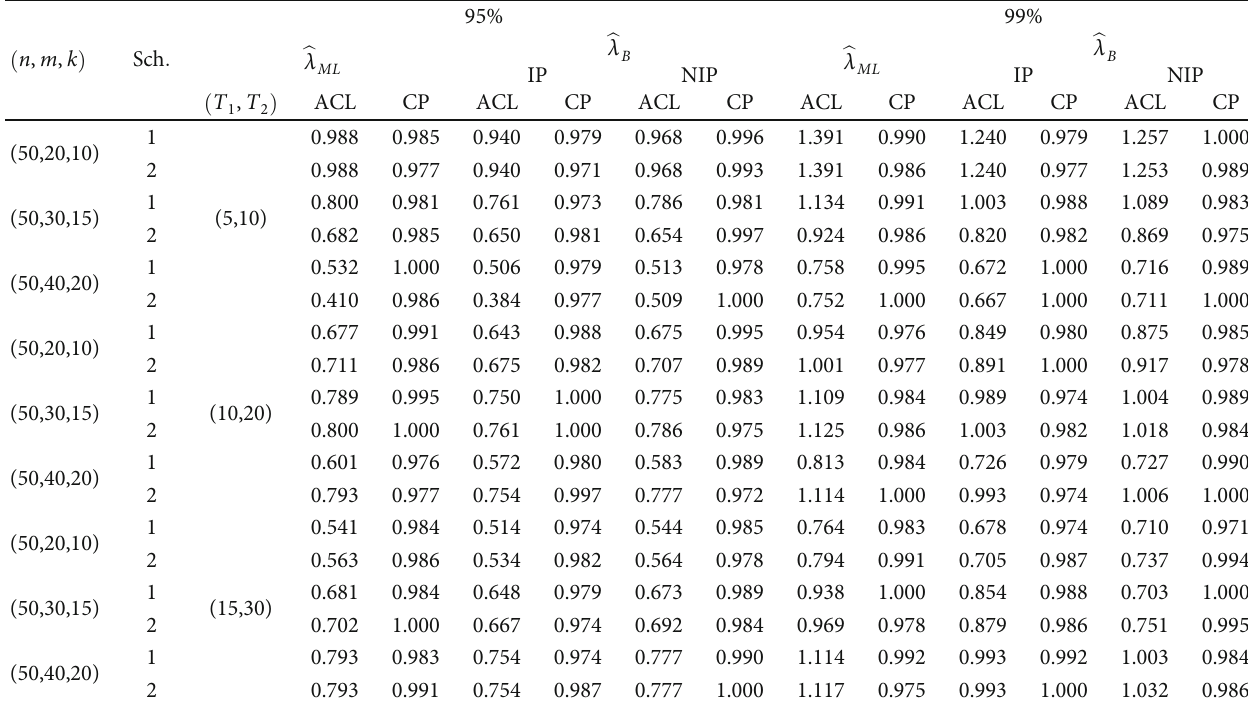
Table 3: The ACL of 95 % and 99 % con fi dence intervals and corresponding CP for b λ PHCSs.